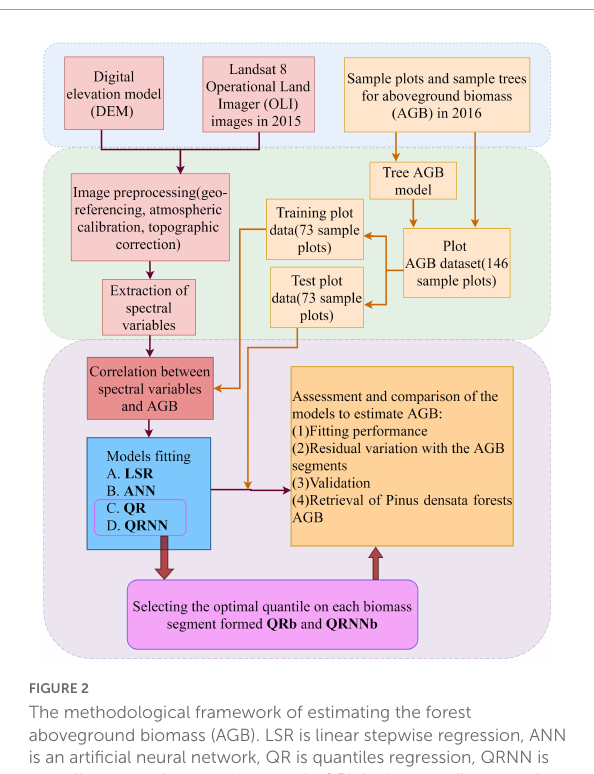
FIGURE2 The methodological framework of estimating the forest aboveground biomass (AGB). LSR is linear stepwise regression, ANN is an artificial neural network, QR is quantiles regression, QRNN is quantiles regression neural network, QRb is the quantile regression with the best fitting performance in each biomass segment, and QRNNb is the quantile regression neural network with the best fitting performance in each biomass